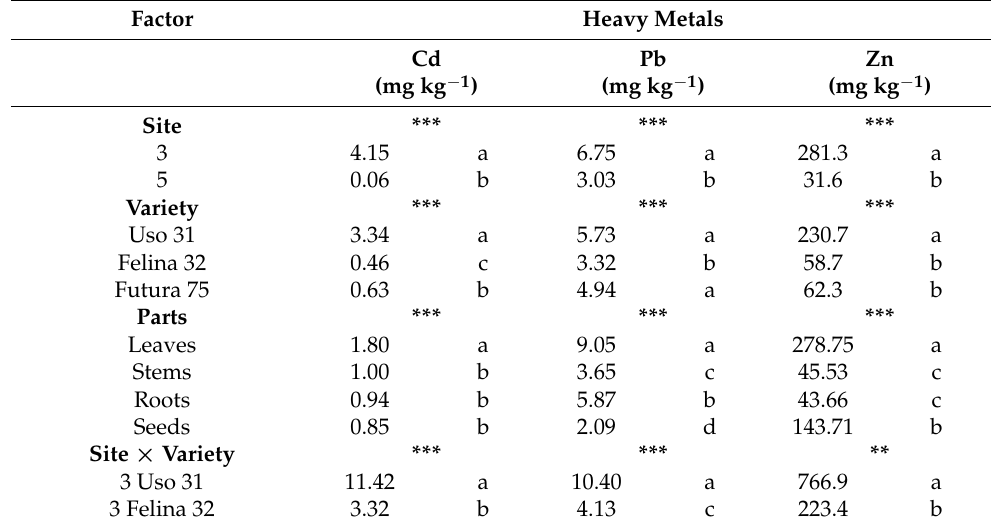
Figure 2. Biplot that represent relations among Cd, Pb and Zn in soil and hemp plants parts. Table 2. Measurements of Cd, Pb and Zn in hemp plants, by variety and plant part, in different